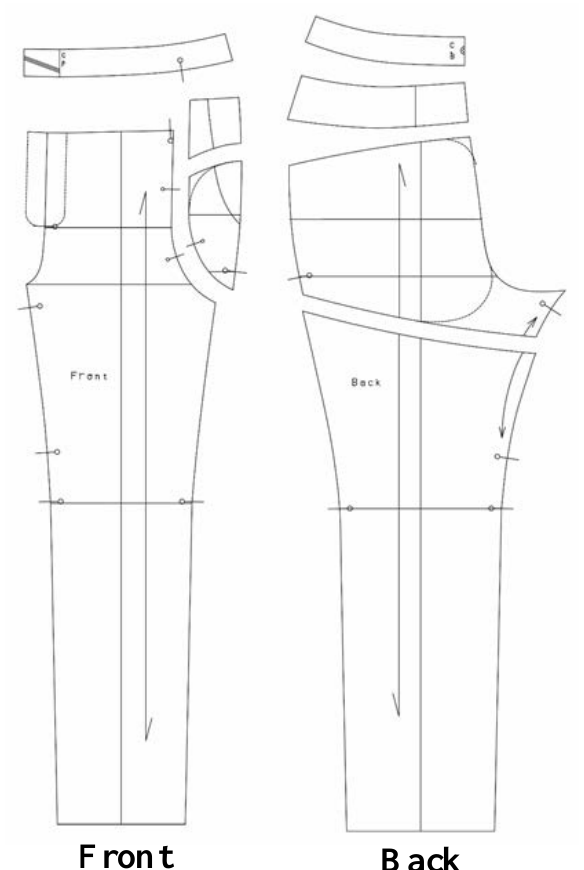
Figure 2. Pattern design for protective pants. Table 1. Properties of the fabrics used in this study.